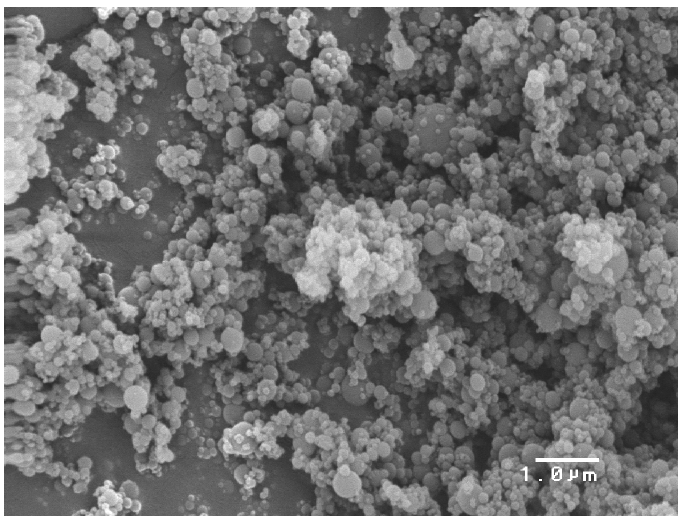
Figure 2. SEM micrograph of micro-silica with spherical appearance of the individual particles.